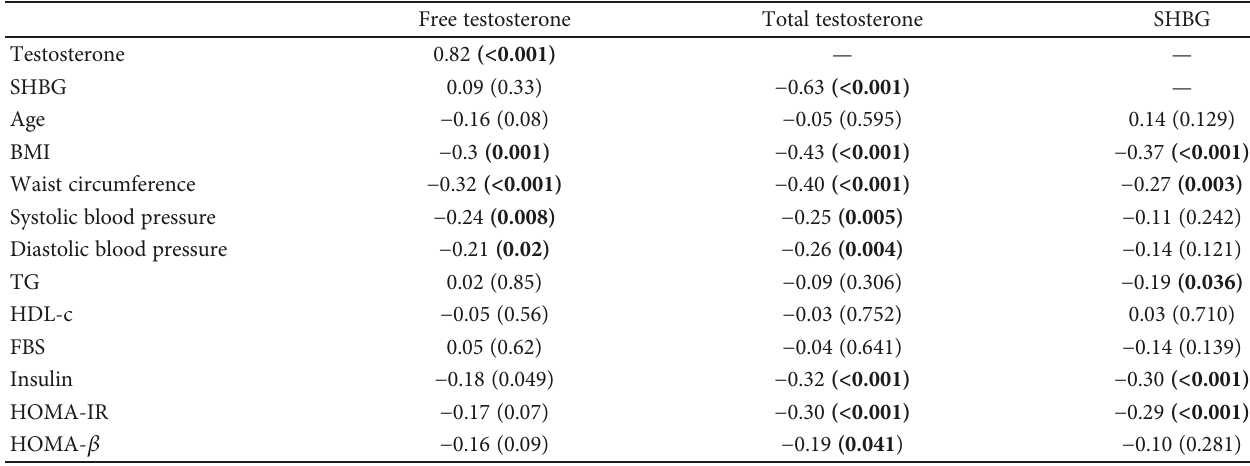
Table 2: Correlation of free and total testosterone and SHBG with metabolic syndrome factors and diabetic parameters.